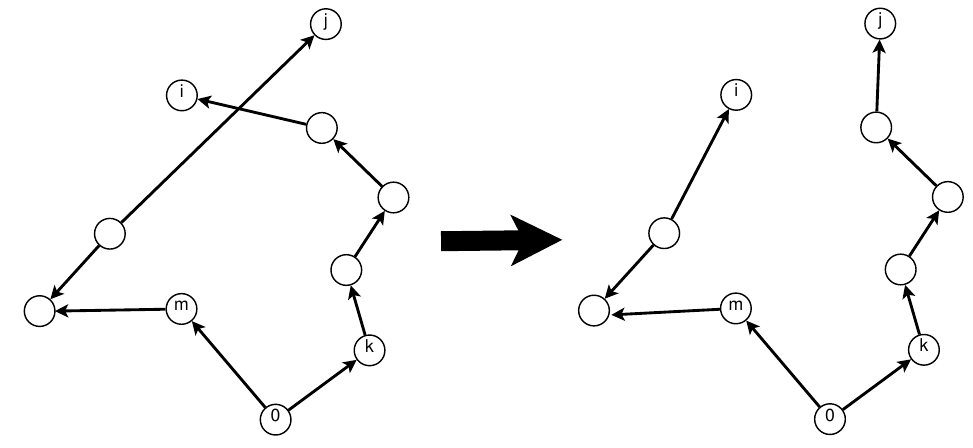
Figure 5. Neighborhood N 1, vertex